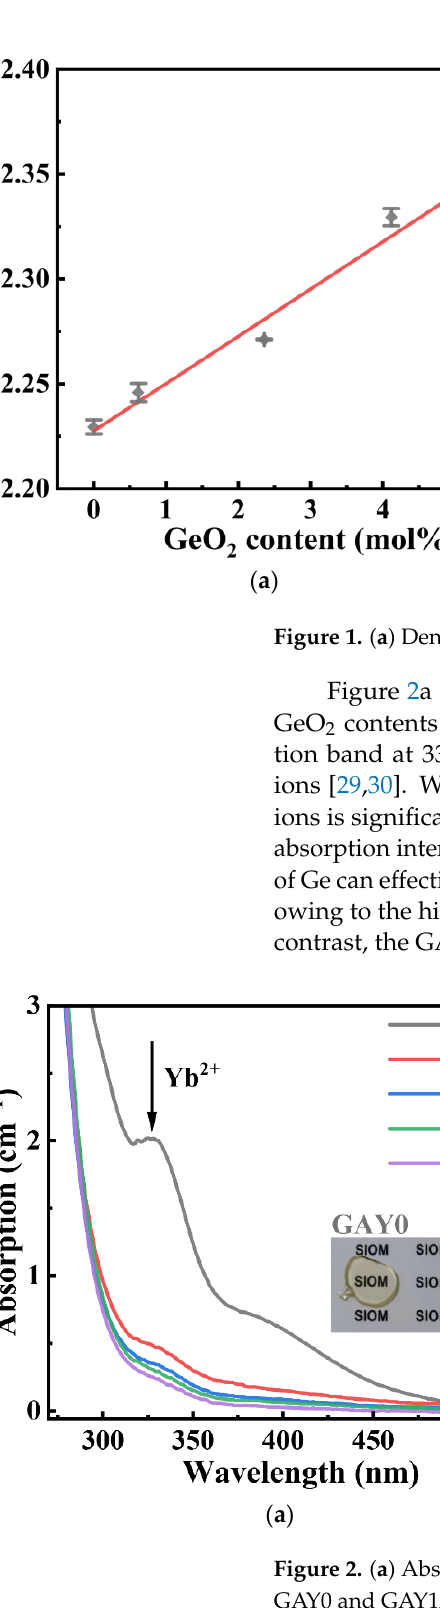
Figure 3. Fluorescence decay curves of Yb 2+ ions and Ge-ODC. Figure 4a,b show the absorption and fluorescence spectra of Yb 3+ ions in the GAY samples. The absorption and emission of Yb 3+ primarily originates from 4f–5d transition [30]. The absorption curves of the samples with different GeO 2 contents roughly overlap, and the absorption intensities of the samples at 976 nm are almost the same. In addition, the fluorescence spectra of the samples under 896 nm excitation roughly coincide. The fluorescence intensity of the Ge co-doped samples is slightly higher than that of GAY0. This may be due to the suppression of Ge co-doping with Yb 2+ ions. This proves that Ge co-doping has no negative impact on the absorption and fluorescence spectra of Yb 3+ ions.